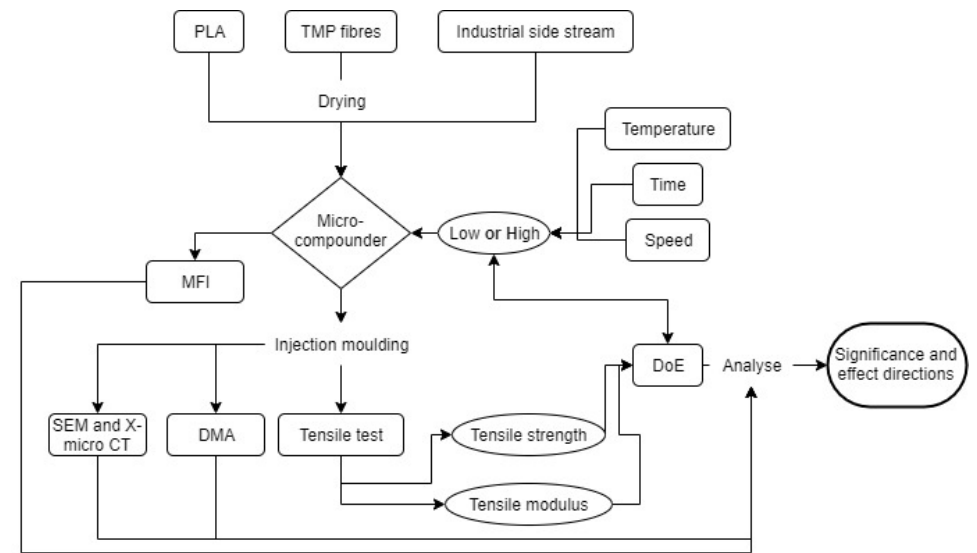
Figure 1. Flow chart to illustrate the research